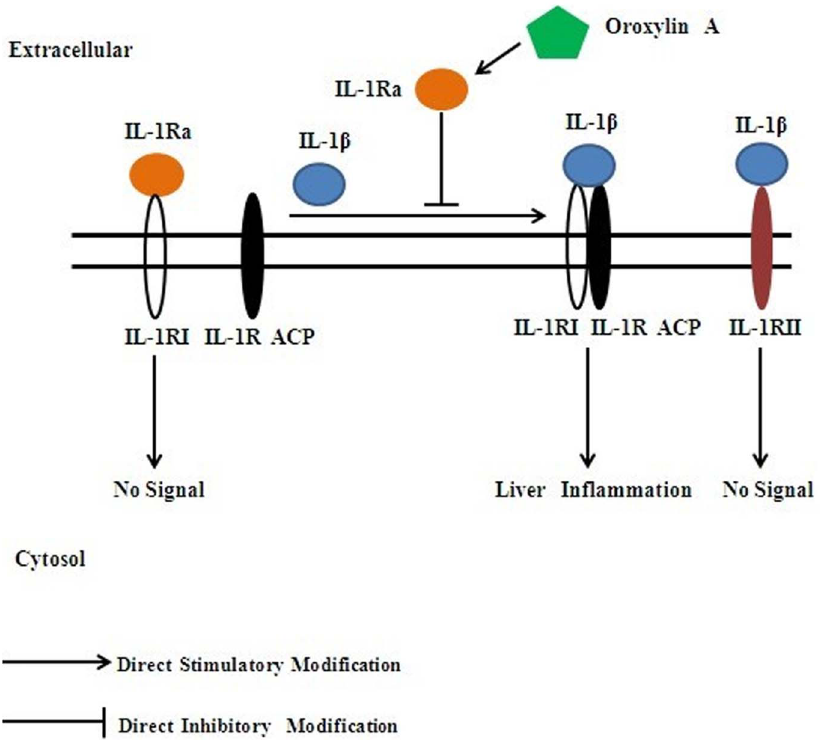
Figure 7. The underlying mechanism of oroxylin A accelerating liver regeneration. Oroxylin A up-regulates the production of IL-1Ra. Meanwhile, it acts as a negative regulator to IL-1 b signaling by binding and blocking the fuctional receptor (IL-1 receptor type-I) without